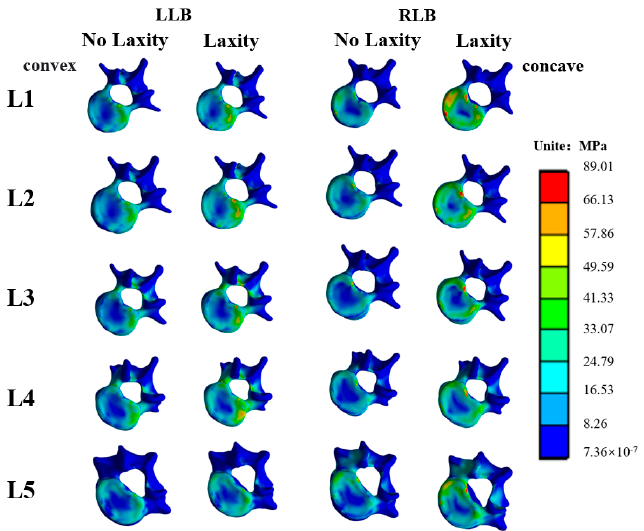
Figure 4. Stress distribution of vertebral body under lateral bending load.